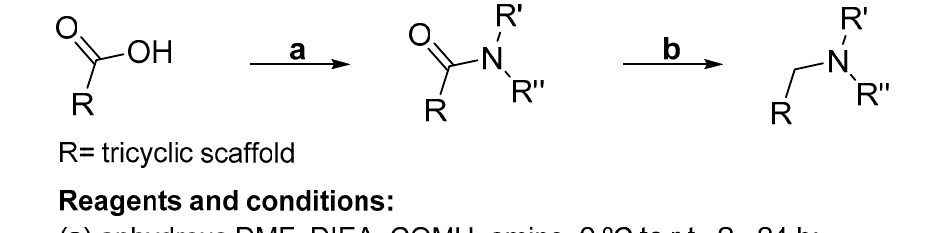
Figure 1. General synthesis of the tricyclic Figure 24. General synthesis of the tricyclic derivatives.